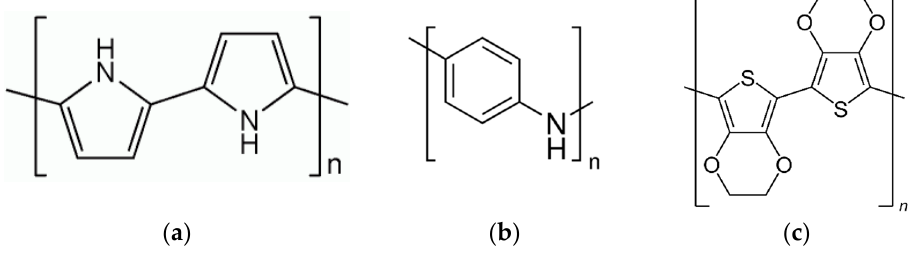
Figure 1. Structures of some conductive polymers: ( a ) PPy; ( b ) PANI and ( c ) PEDOT.